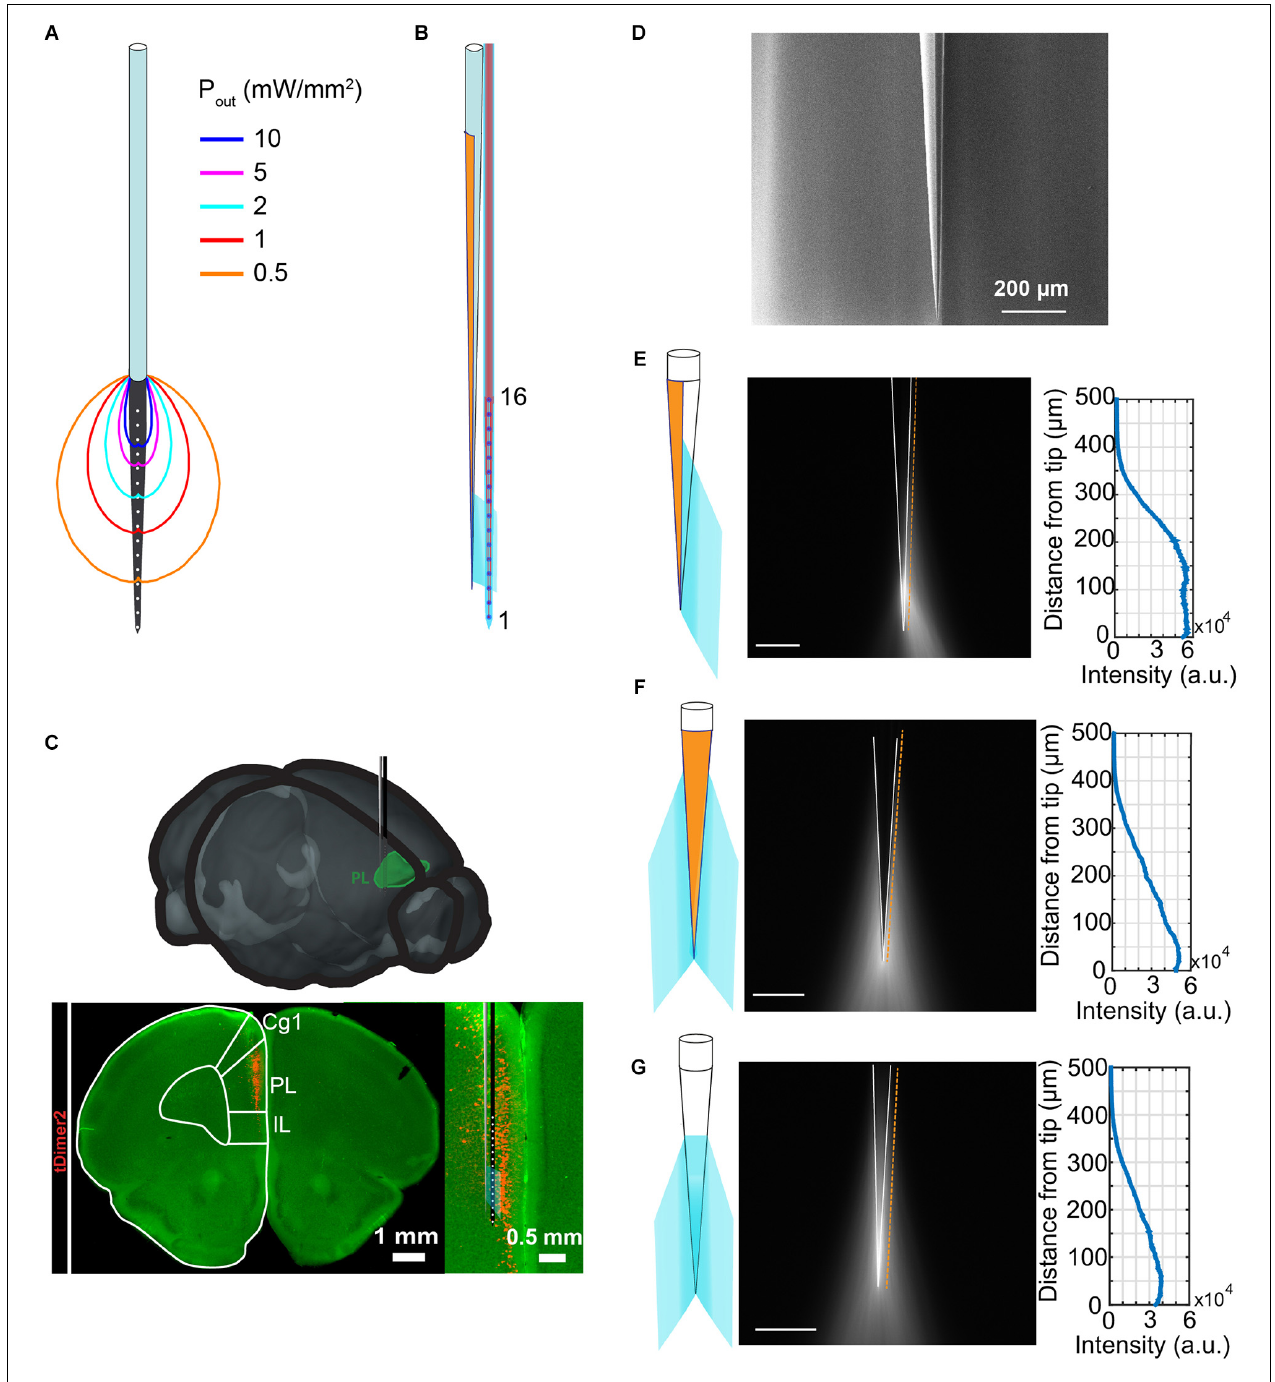
FIGURE 1 | Tailoring light delivery to a subregion of mPFC. (A) Representation of a commercially available optrode (A1 × 16-3mm-100-703-OA16LP, light fiber terminates 200 µ m from the top recording site) and power density distribution iso-lines obtained with Monte-Carlo simulations for a total power of 1 mW delivered to the tissue. (B) Schematic representation of the optrode designed in this work, consisting of a half-metallized TF beside a multielectrode array. (C) Schematic overview of recording setup of the prelimbic subdivision of the mPFC. Digital photomontage reconstructing the position of the designed opto-electrode in the PL of a P9 mouse after IUE with ChR2(ET/TC) and tDimer2 (red) at embryonic age (E)15.5. Inset, optical light fiber (gray) and electrode shank (black) including the position of the recording sites (white) over the prelimbic depth are displayed at higher magnification. (D) Typical scanning electron microscope image of the realized TF. (E–G) Emission properties of the realized TF (side view) in a cartoon (left) and with the TF submerged in fluorescein:PBS droplet (center). Half of the taper is coated with ∼ 5 nm of Cr and ∼ 200 nm of Au. The graph (right) shows the emission profile acquired along the orange line in the center panel (scale bars represent 100 µ m).